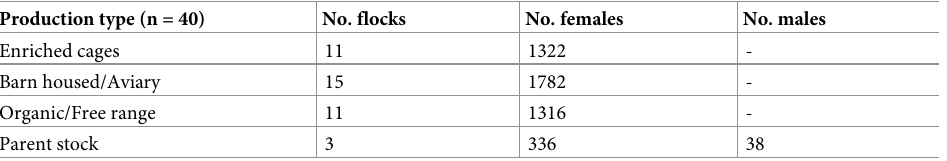
Table 1. Overview of the flocks and birds in the different production